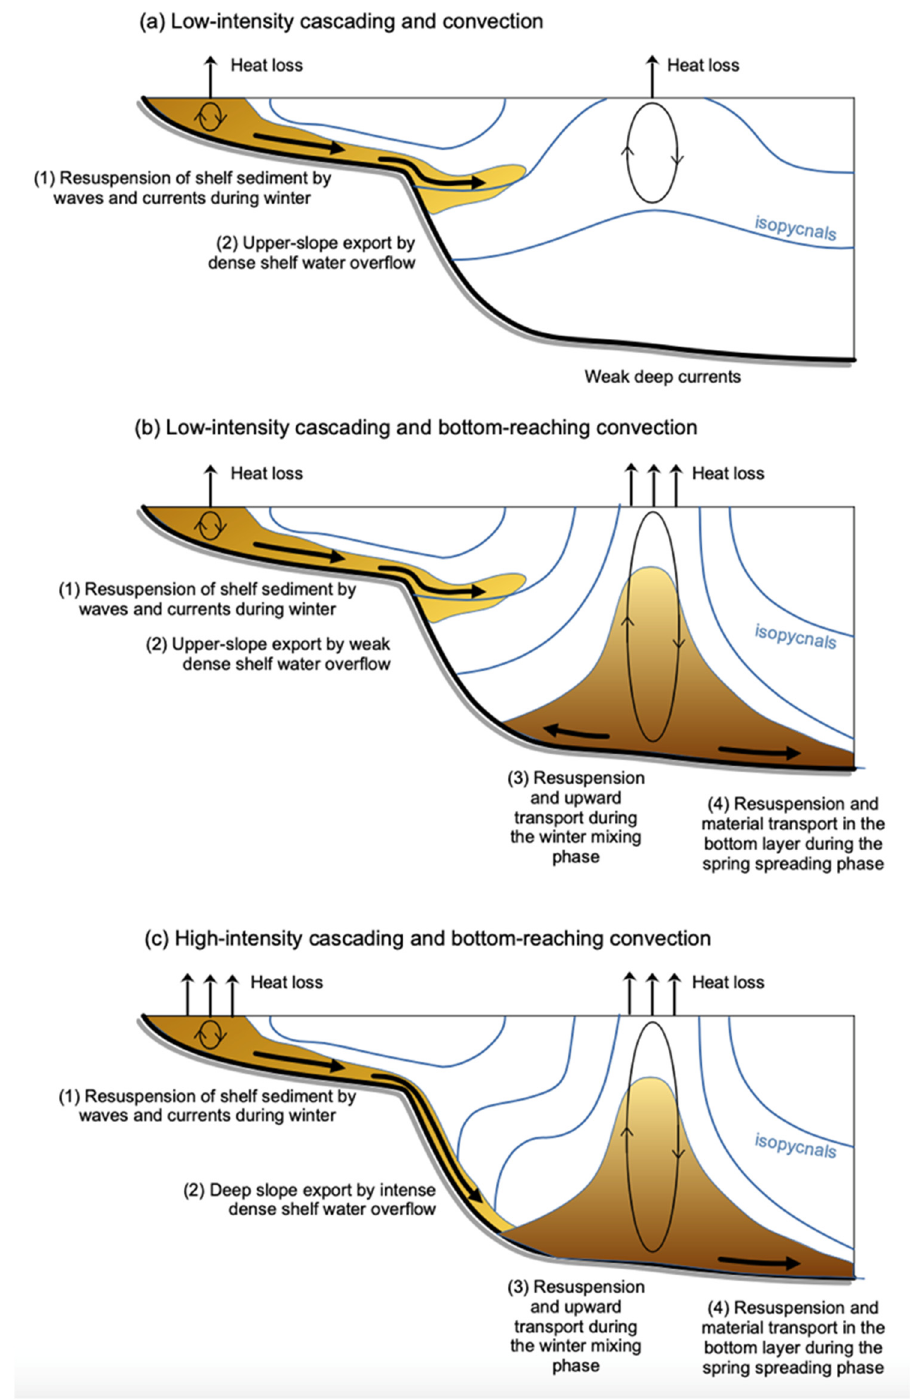
Figure 7. Sketches of the transport pathways of particulate fluxes from the coastal zone to the The effect of deep convection on sediment resuspension in the Gulf of Lions basin deep basin for different scenarios ( a ) during a severe winter event of dense shelf water cascading was suggested by [27] based on the first near-bottom particle trap measurements per- and bottom-reaching convection in the northwestern Mediterranean (winter 2012 and 2013 events), formed between 2007 and 2009. This effect was confirmed and detailed by [28]. These au- ( b ) during a severe E–SE storm (winter 2011), and ( c ) during a bottom-reaching convection only event. thors showed that during the winter of 2013, as convection reached the bottom, bottom Black arrows to the atmosphere indicate heat loss, those in the water column indicate vertical mixing currents larger than 25 cm/s were able to resuspend the surface sediments from the deep and lateral transport. Surfaces with the same density (isopycnals) are delineated by blue basin and generate a bottom nepheloid layer, with a maximum thickness of more than 2000 m, under the effect of strong vertical currents (up to 20 cm/s) present during the intense mixing phase. During the deep-water dispersion phase, which occurs when the convective mixing subsides and the water column restores itself, the bottom currents